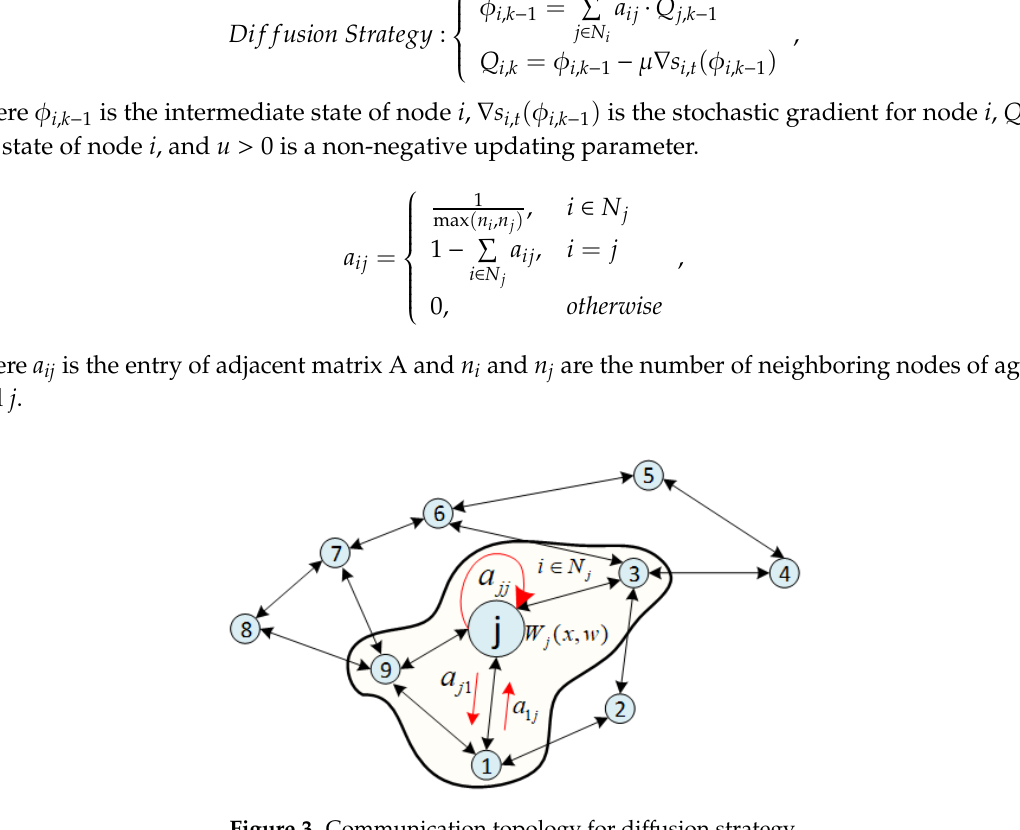
Figure 3. Communication topology for diffusion strategy.